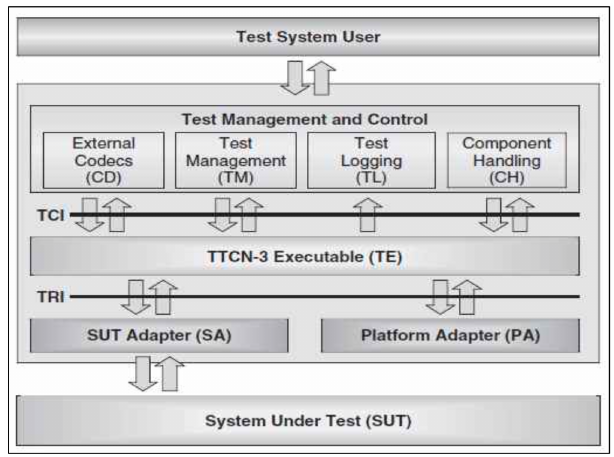
Figure 6. Testing and Test Control Notation (TTCN) testing